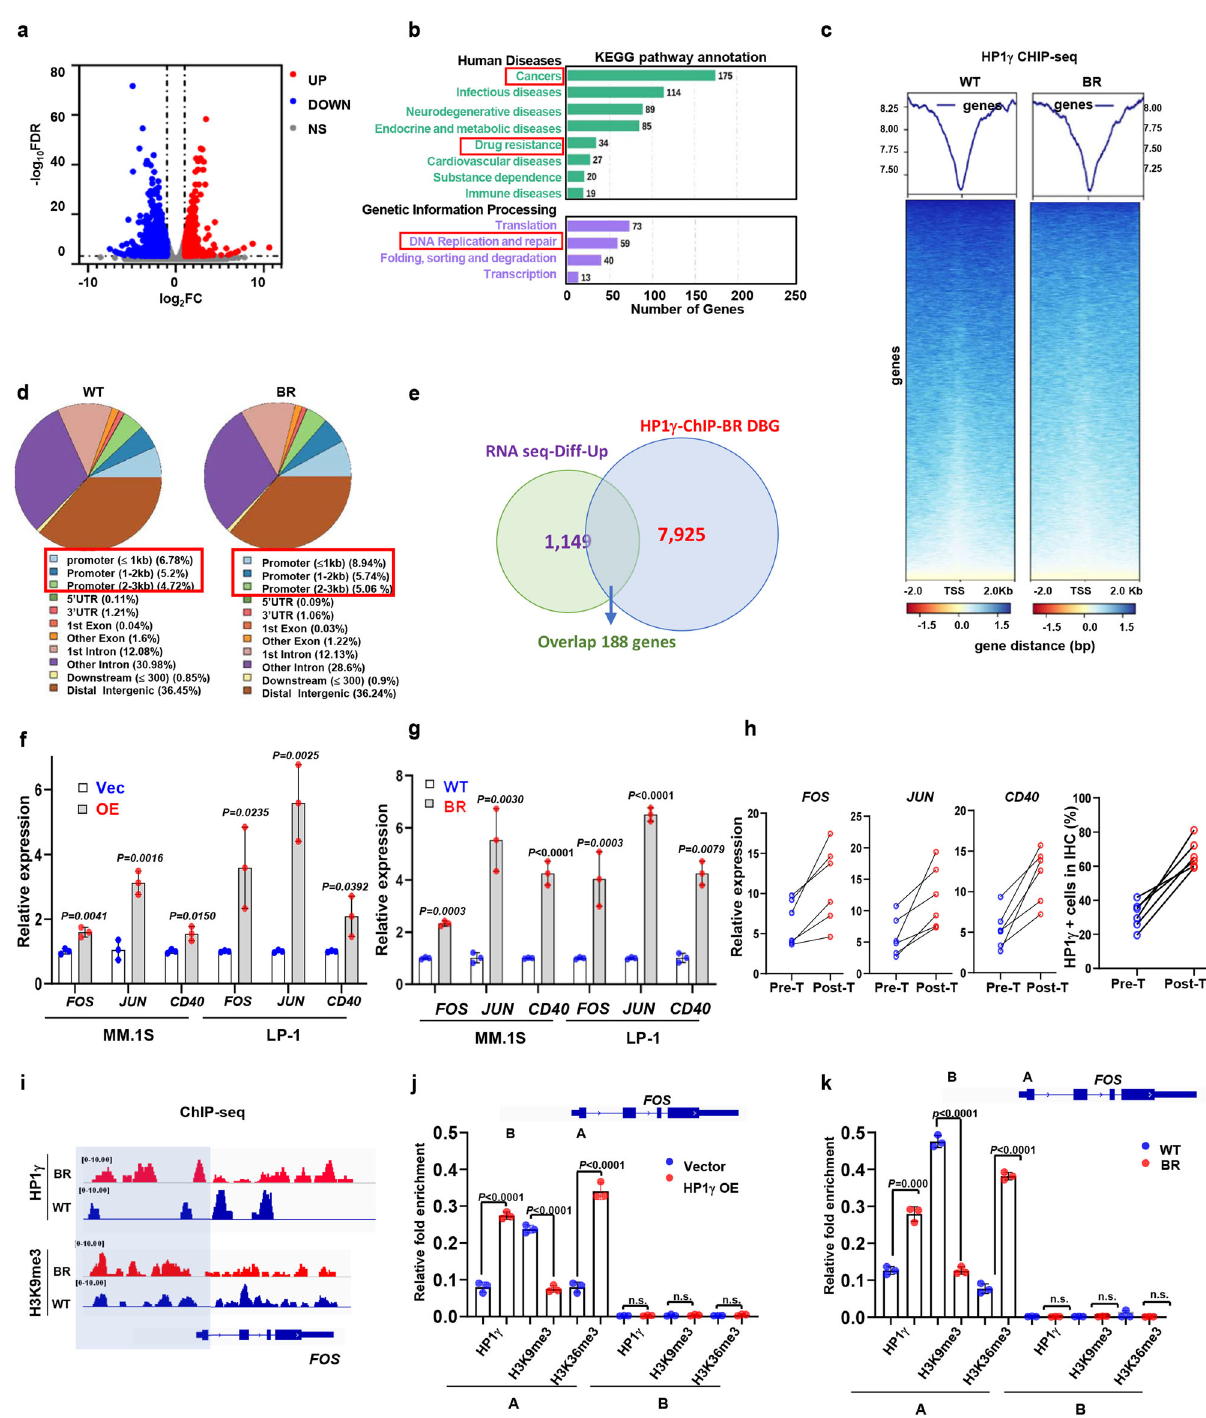
Fig. 6 | HP1 γ promotes expression of genes associated with MM drug resis- tance. a Volcano plot of differentially expressed genes analyzed from bulk RNA- sequencing in HP1 γ overexpressing LP-1 cells. Blue, downregulated genes; red, upregulated genes; gray, statistically non-signi fi cance genes. b KEGG analysis for differentially expressed genes with a P <0.05 using DAVID methods. c ChIP-seq pro fi le of genes enriched by HP1 γ in WT and BR LP-1 cells ( n = 3 biologically independent experiments). d Pie chart to show percentages of HP1 γ binding on gene locations. e Venn diagram shows the number of overlapped genes between HP1 γ -ChIP and HP1 γ overexpression RNA seq. QPCR shows expression of FOS, JUN and CD40 expressionsin( f )theHP1 γ overexpressing,( g )WTandBRMM.1SandLP-